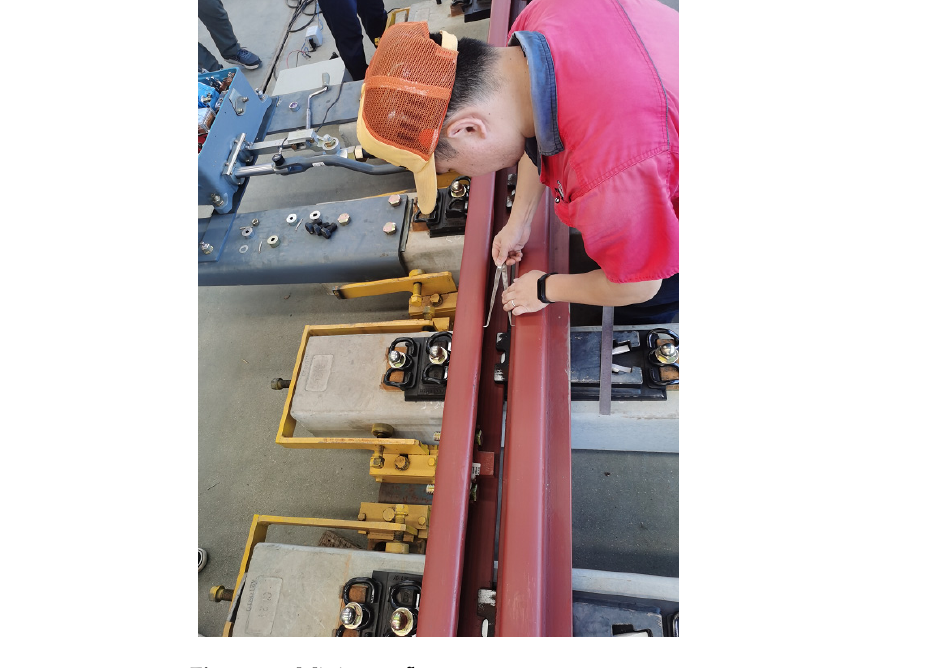
Figure 11. Minimum flangeway test. After the pre-switching, the switch was flipped back and forth three times. The switching force at different traction points during each flip and the test result of the corresponding minimum flangeway after the flip are shown in Tables 5 and 6, respectively. Table 5. Turnout switching force (N).